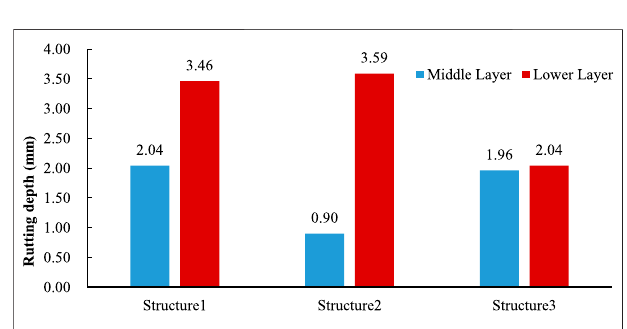
FIGURE 9 | APA rutting test results of asphalt mixtures for each pavement structure (mm).